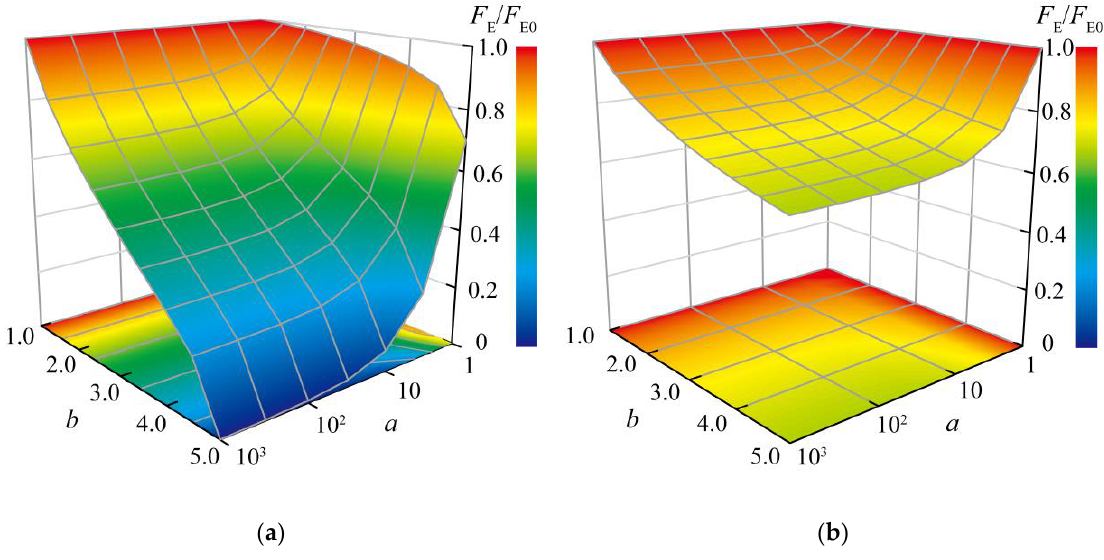
/ F F with parameters a and b . ( a ) / 5 h r = ; ( b ) / 50 h r = . Figure 5. Variation in Figure 5. Variation in F E / F E0 with parameters a and b . ( a ) h / r L = 5; ( b ) h / r L = 50. E E0 L L As shown in Figure 5, F E / F E0 decreases with increasing parameters a and b . F E / F E0 / F F decreases from 100% to 70.21% as b increases from 1 to 5, On the one hand, is always equal to 1, regardless of the value of a and h / r L when b = 1. When b = 5 and E E0 h / r L = 5, F E / F E0 decreases from 70.21% to 0.07%, as a increases from 1 to 1000. When / 5 h r = , and it decreases from 100% to 99.95% as b increases from 1 to when = 1 a and L b = 5 and h / r L = 50, F E / F E0 decreases from 99.95% to 65.03%, as a increases from 1 to / 50 h r = . On the other hand, / F F decreases from 100% to 0.07% 5, when = 1 a and 1000. The results above suggest that F E / F E0 decreases with increasing a , and the variation L E E0 / 5 h r = , and it decreases from 100% to amplitude of F E / F E0 increases as the EDZ becomes thicker and h / r L decreases. as b increases from 1 to 5, when = 1000 a and L On the one hand, F E / F E0 decreases from 100% to 70.21% as b increases from 1 to 5, / 50 h r = . The results above indi- 65.03% as b increases from 1 to 5, when = 1000 a and L when a = 1 and h / r L = 5, and it decreases from 100% to 99.95% as b increases from 1 to 5, / F F decreases as the EDZ becomes thicker, and the variation amplitude in- cate that when a = 1 and h / r L = 50. On the other hand, F E / F E0 decreases from 100% to 0.07% as b E E0 increases from 1 to 5, when a = 1000 and h / r L = 5, and it decreases from 100% to 65.03% / h r decreases. Therefore, the var- creases as the permeability of EDZ increases and the L as b increases from 1 to 5, when a = 1000 and h / r L = 50. The results above indicate that / F F as the tunnel is buried iations in EDZ parameters a and b have a greater impact on F E / F E0 decreases as the EDZ becomes thicker, and the variation amplitude increases as the E E0 permeability of EDZ increases and the h / r L decreases. Therefore, the variations in EDZ more shallowly. parameters a and b have a greater impact on F E / F E0 as the tunnel is buried more